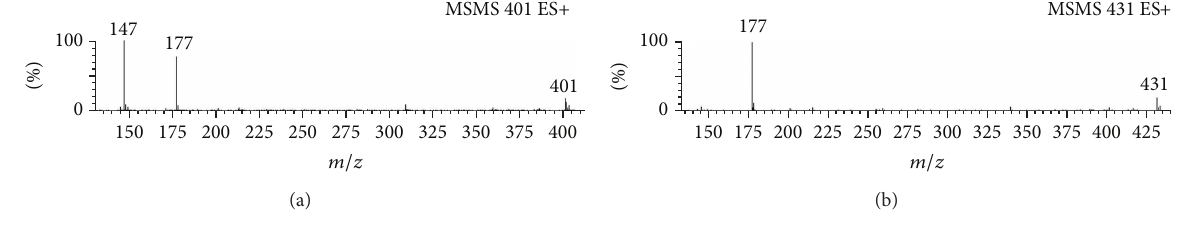
Figure 4: CID-MS/MS spectra of ion [dCurc-H + Zn] + ((a) CE = 15V) and [Curc-H + Zn] + ((b) CE = 15 V).